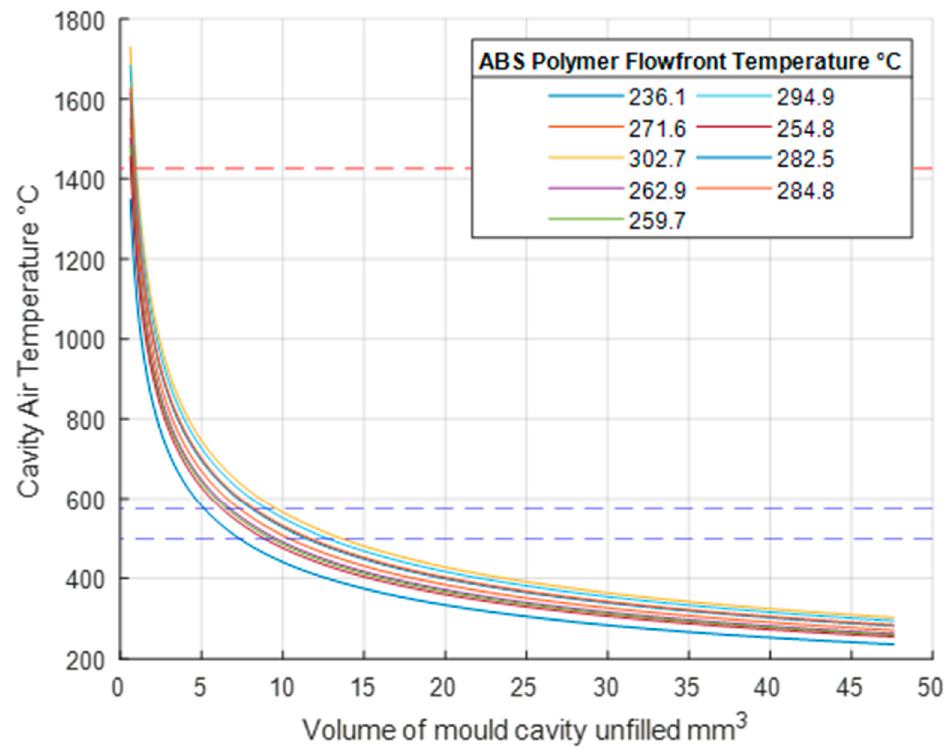
Figure 8. Adiabatic temperature increase when air is compressed in mould, ABS.